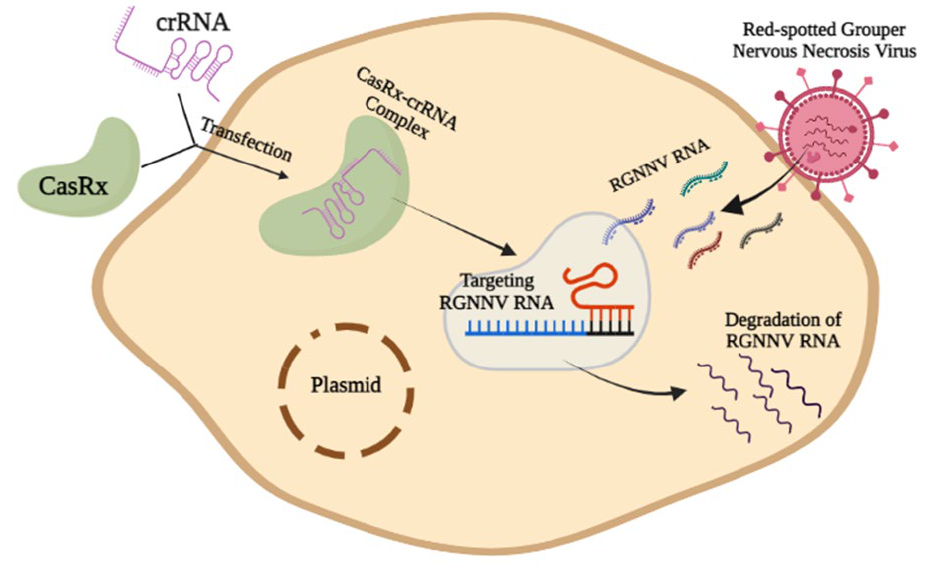
Figure 3. The in vitro RGNNV targeting via the CasRx system.